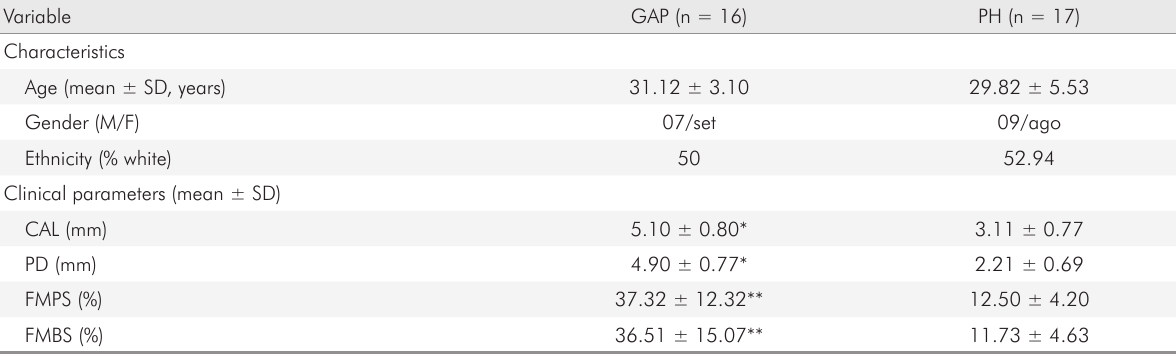
Table 2. Demographic characteristics of the study population and clinical parameters. Variable